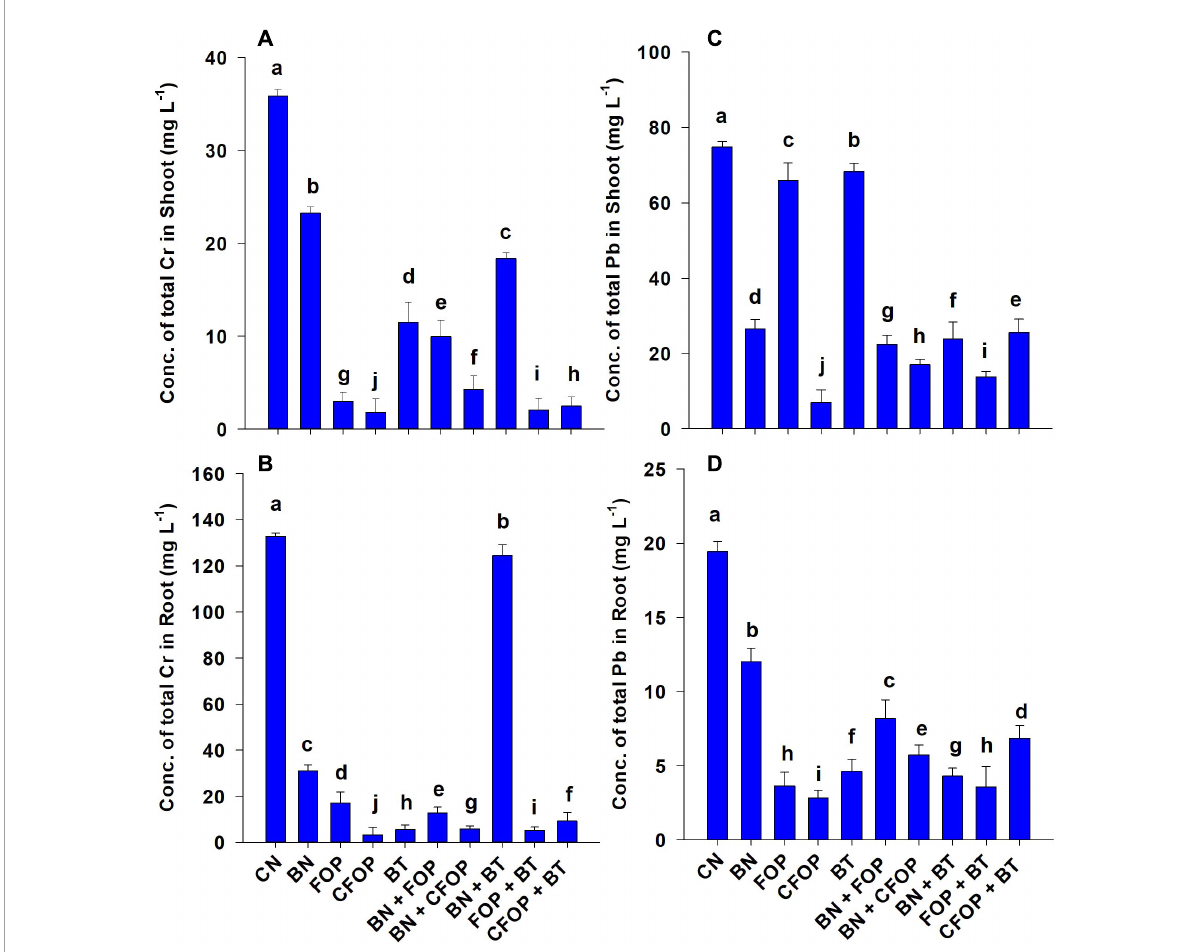
FIGURE3 Concentrations of total Cr and Pb (mg L − 1 ) in stem (A,C) and root (B,D) of brinjal plant ( Solanum melongena ) as affected by various treatments: Control (CN); bentonite (BN); Iron Oxide nanoparticles (FOP); Cerium-doped iron oxide nanoparticles (CFOP); Azotobacter nigricans sp. (BT); BN + FOP; BN + CFOP; BN + BT; FOP + BT; T10 = CFOP + BT. At ( P < 0.05) column with changed letters are significantly